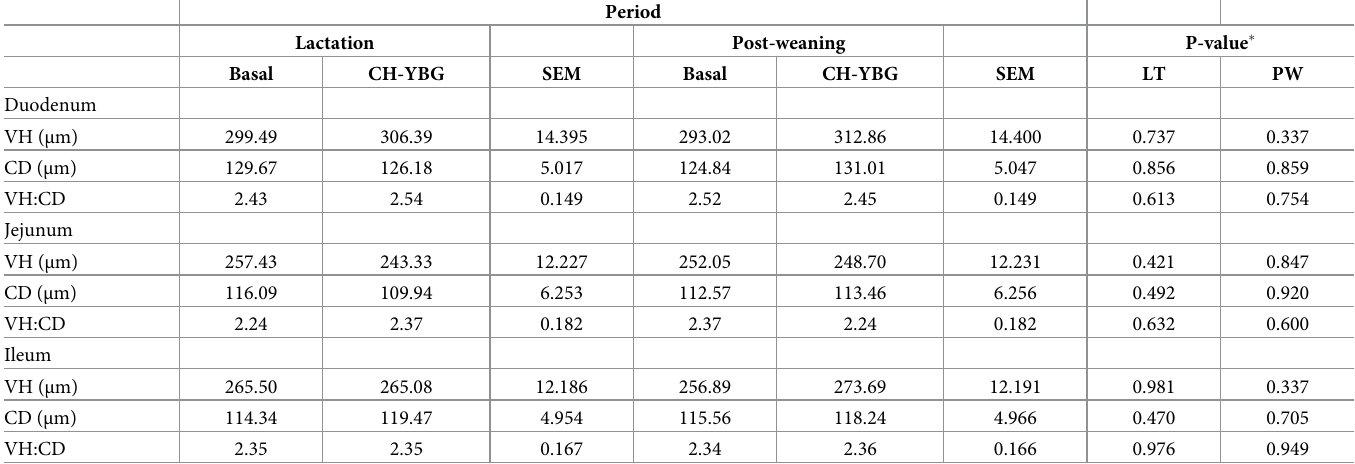
CH-YBG, casein hydrolysate plus a yeast β -glucan; VH, villus height; CD, crypt depth; LT, lactation diet; PW, post-weaning diet. � There was no LT × PW interaction.